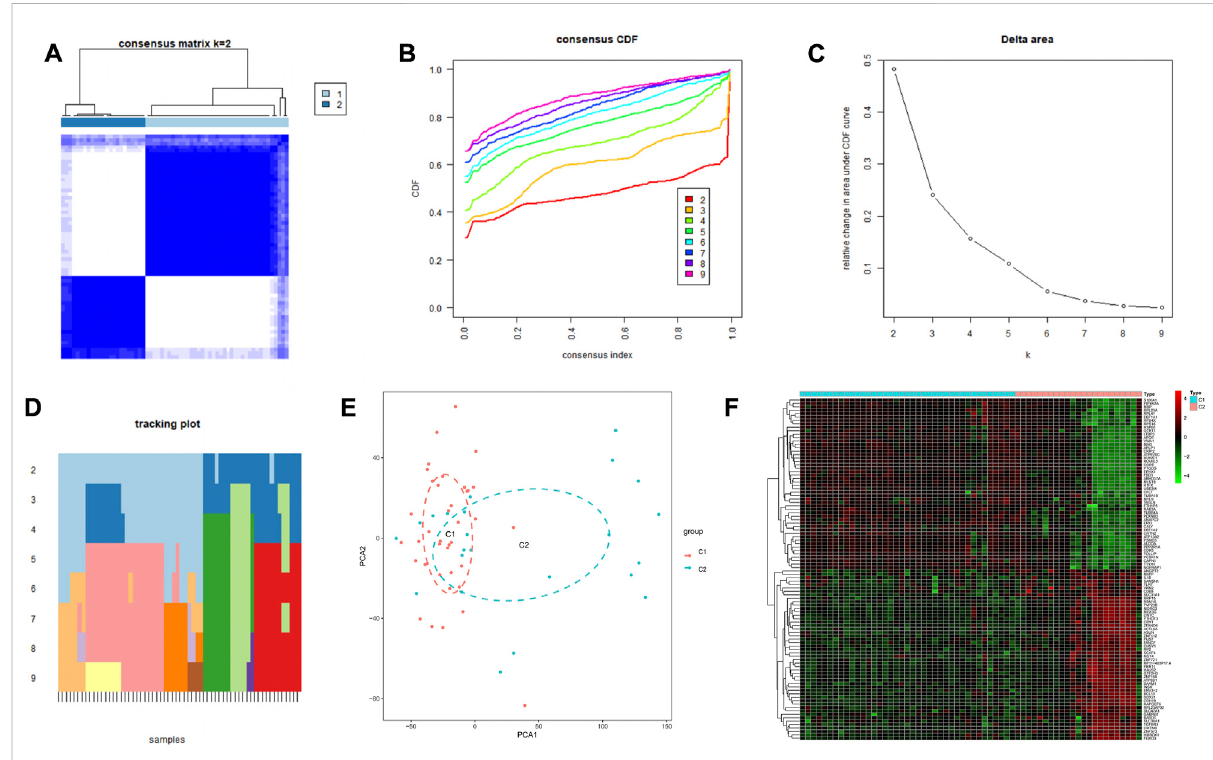
FIGURE 6 Construction of two subpopulations based on cuprotosis-related genes in the GEO cohort. (A) Heat map of the consensus matrix at k = 2. (B) Consensus CDF at k = 2 – 9. (C) Relative change in area under the CDF curve. (D) Trace plot of sample classi fi cation when k = 2 – 9. (E) 3DPCA plot showing that cuprotosis-associated genes effectively classify Parkinson ’ spatients into two subgroups (C1 and C2). (F) Heat map showing differential gene expression in the two immune